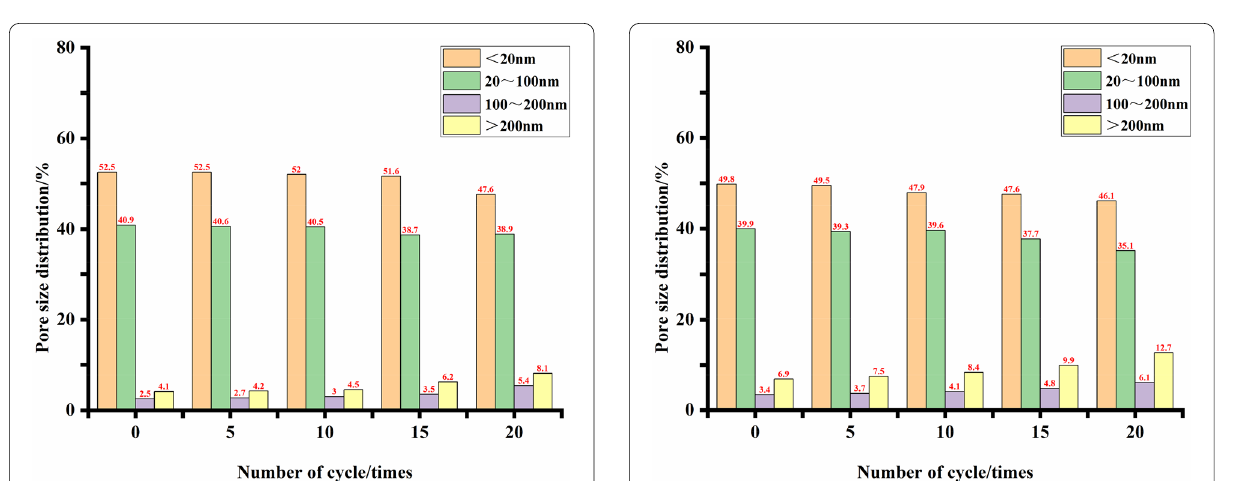
Fig. 15 The pore size distribution of concrete at different single-side salt-freezing–drying–wetting cycles